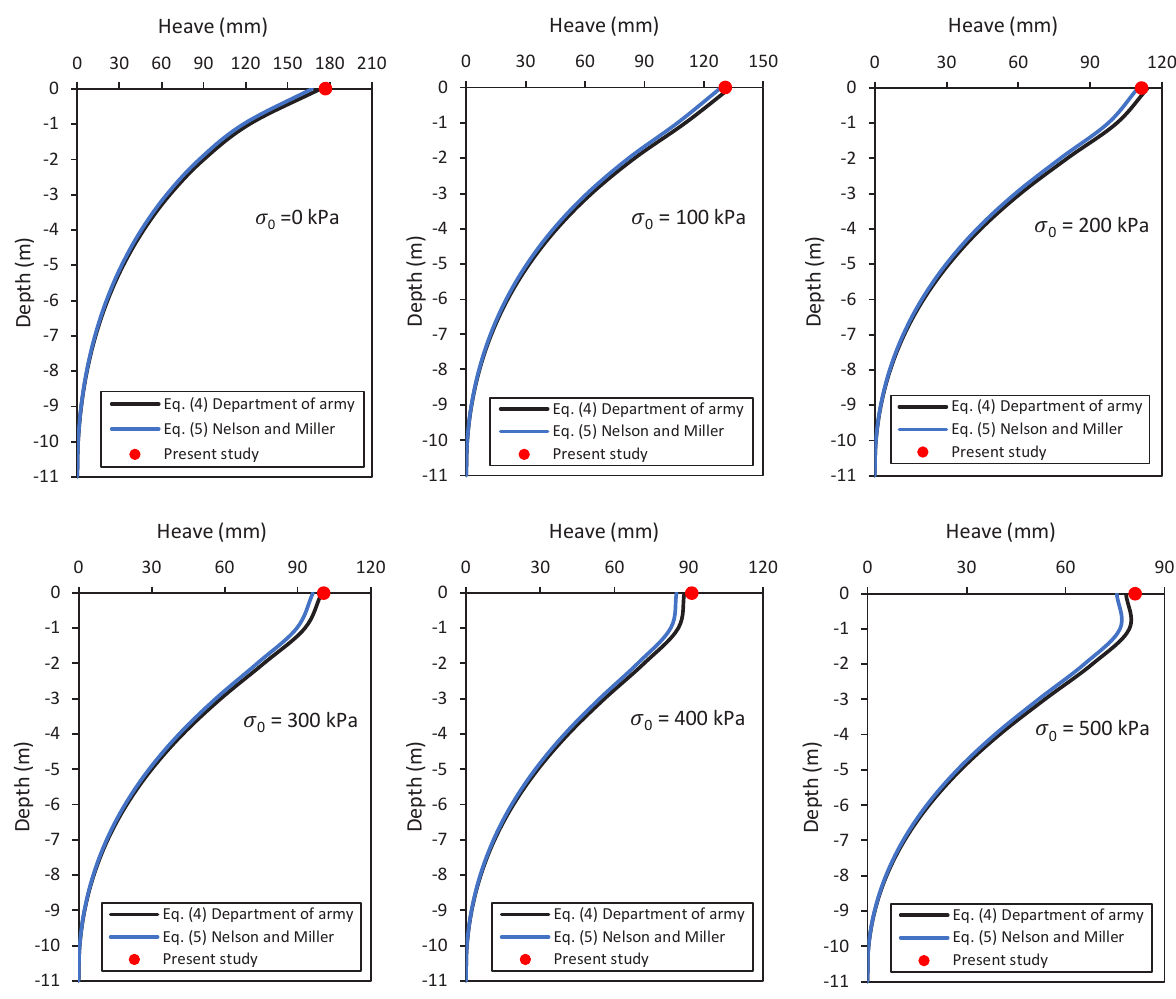
Figure 10: Comparison between numerical and analytical results of heave evolutions throughout the soil depth. Case of square footing of width B=1m and σ =0 to 500 kPa. 0